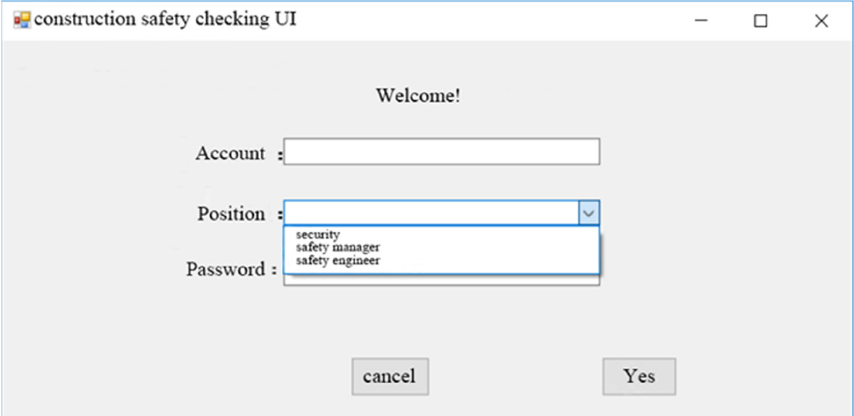
Figure 21. Landing interface of the developed safety risk inspection system.